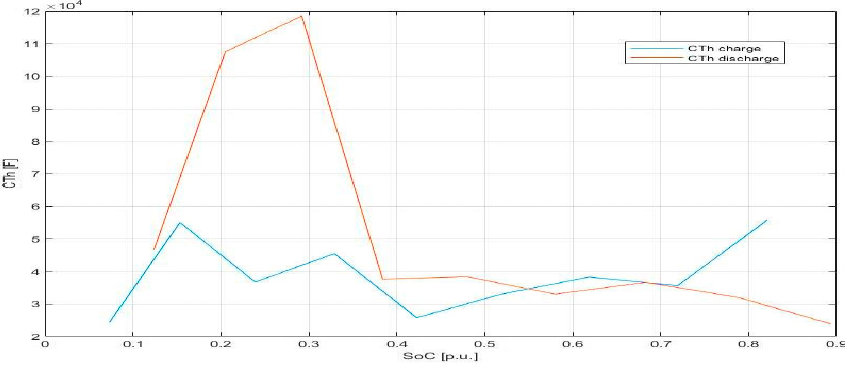
Figure 12. C th at di ff erent values of SoC. Figure 12. (cid:1829) (cid:3047)(cid:3035) at different values of SoC.